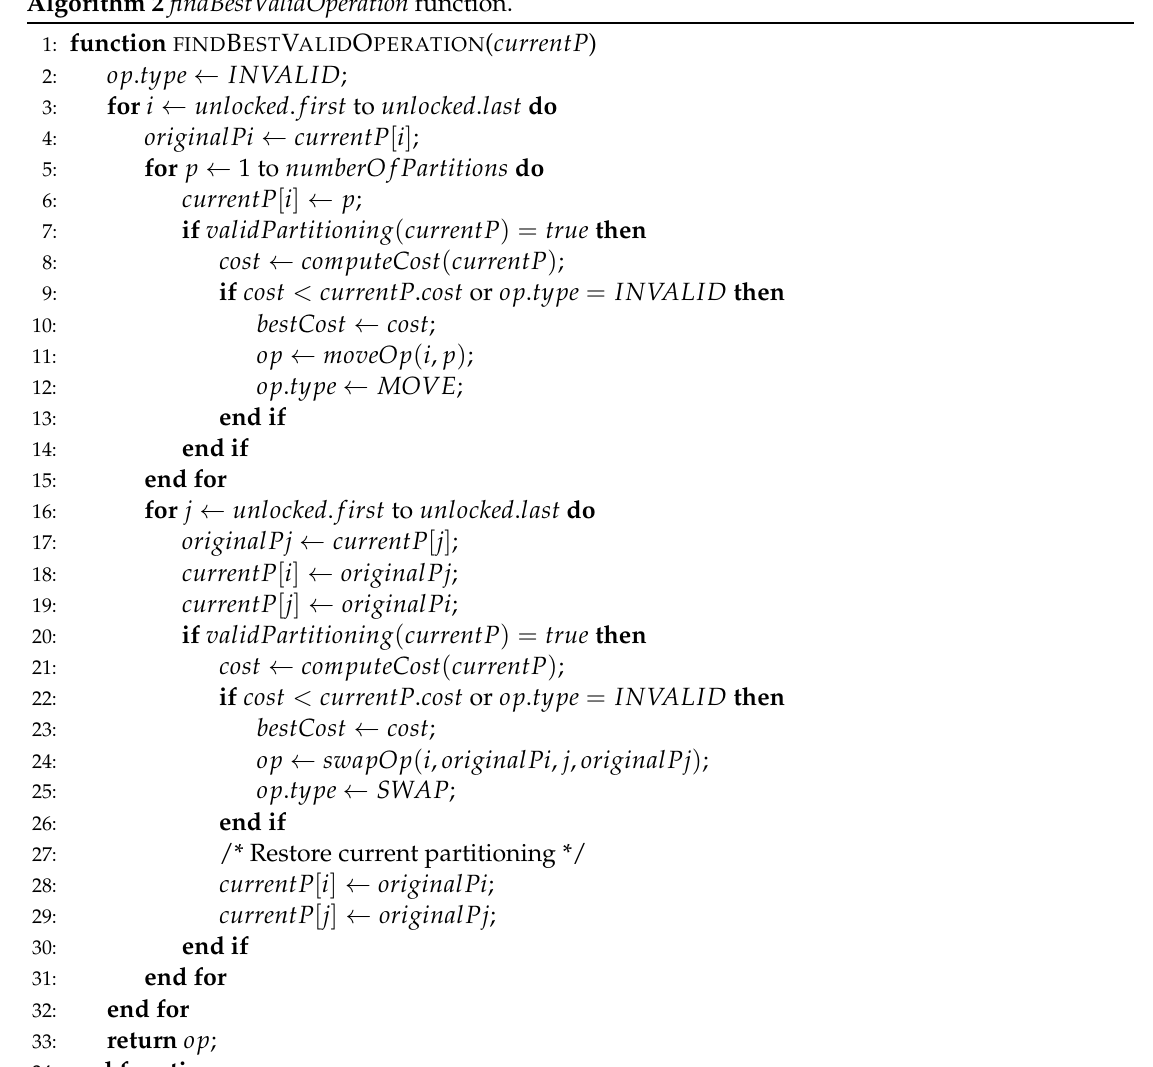
Algorithm 2 findBestValidOperation